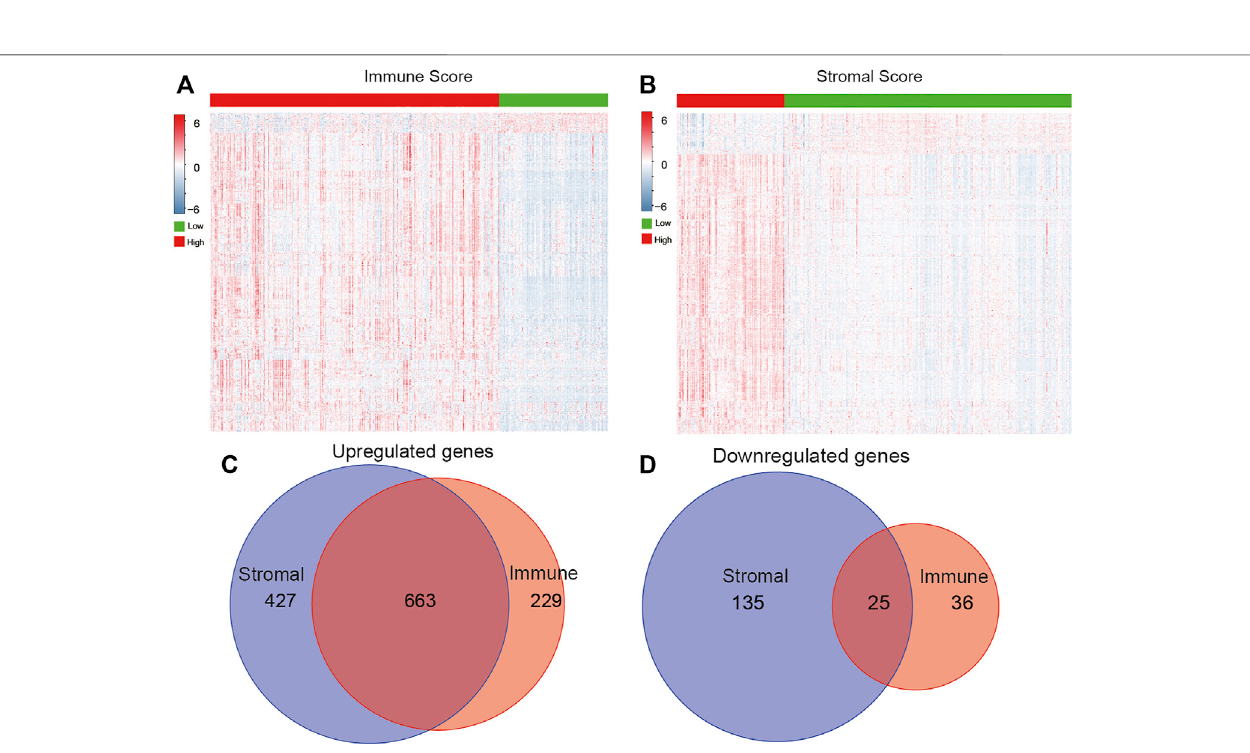
FIGURE 3 | Identi fi cation of DEGs based on immune/stromal scores. Heatmap of DEGs from the low vs. high immune (A) /stromal (B) score groups (|fold change| > 1.5, p < 0.05). Venn diagrams showed the number of overlapped up- or downregulated DEGs in immune score (C) and stromal score (D) groups.